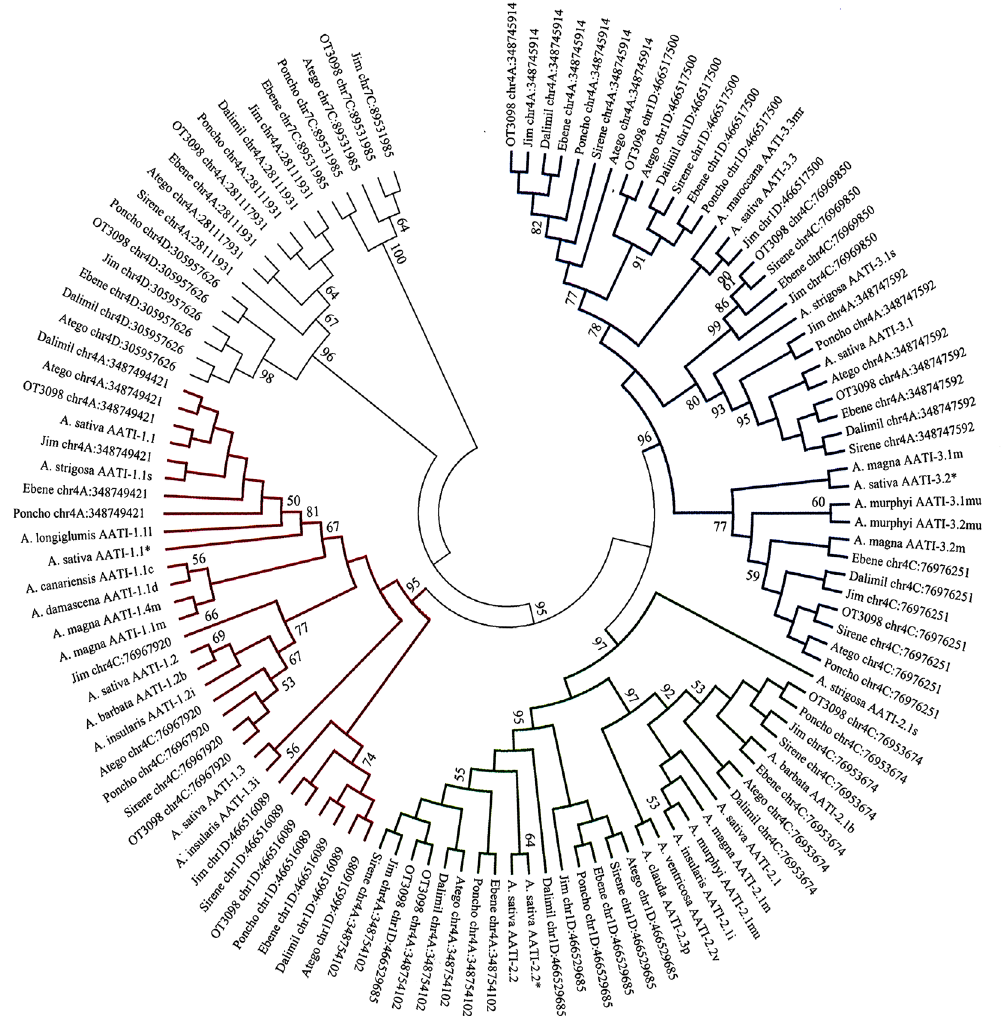
Figure 4. Molecular Phylogenetic analysis of AATIs by Maximum Likelihood method based on the Jukes- Cantor model Bootstrap consensus tree inferred from 1000 replicates. Branches corresponding to partitions reproduced in less than 50% of bootstrap replicates are collapsed. The analysis involved 121 nucleotide sequences; there were a total of 723 positions in the final dataset. Colours correspond to the group of α-amylase trypsin inhibitor: red—AATI 1; green—AATI 2; blue—AATI 3; black—unknown group of